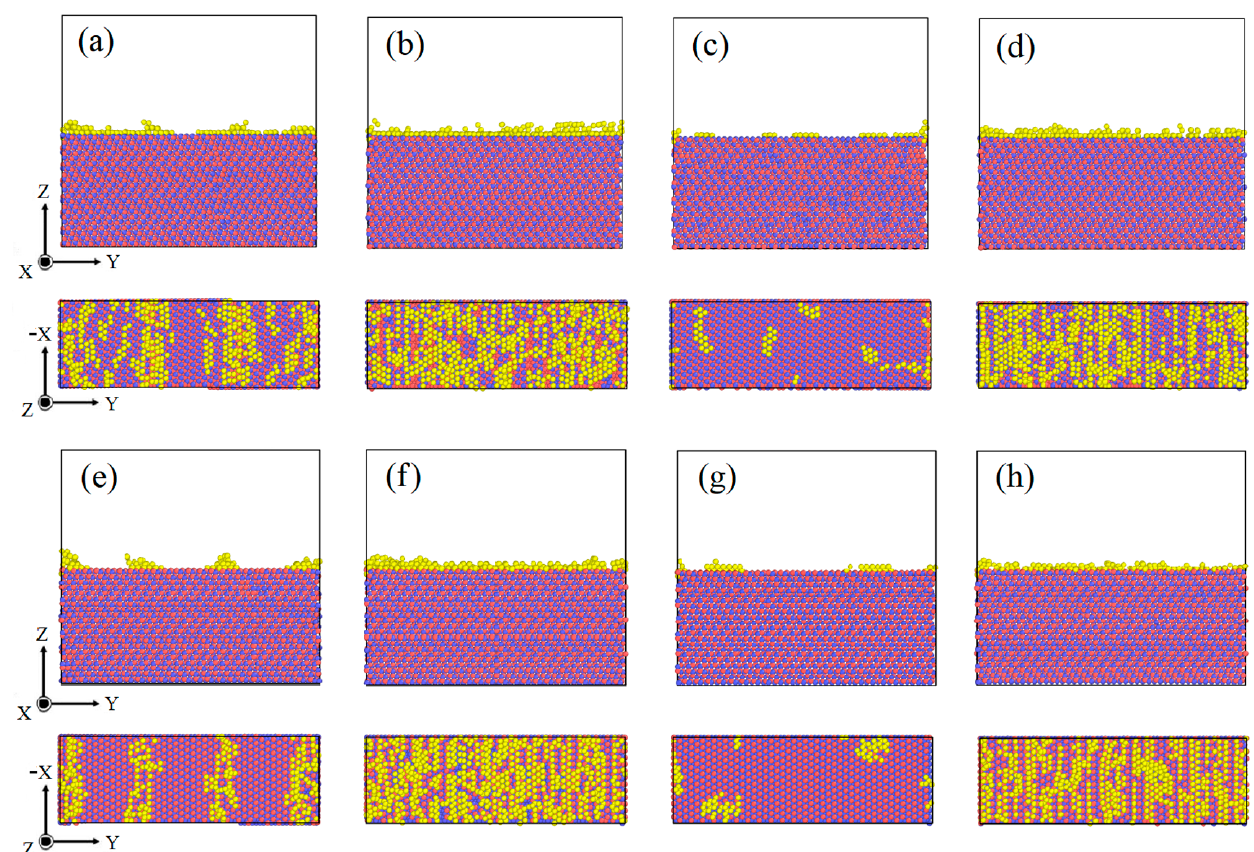
Figure 3. Snapshots of relaxed structures of eight SiC(0001)/Al models colored using the Wigner– Seitz defect analysis. Al-atoms offsetting the original FCC lattice space are colored yellow, C-atoms are colored red, and Si-atoms are colored blue. ( a ) SiC(0001)-Si/Al(001), ( b ) SiC(0001)-Si/Al(110), ( c ) SiC(0001)-Si/Al(111), ( d ) SiC(0001)-Si/Al(112), ( e ) SiC(0001)-C/Al(001), ( f ) SiC(0001)-C/Al(110), ( g ) SiC(0001)-C/Al(111), ( h ) SiC(0001)-C/Al(112).